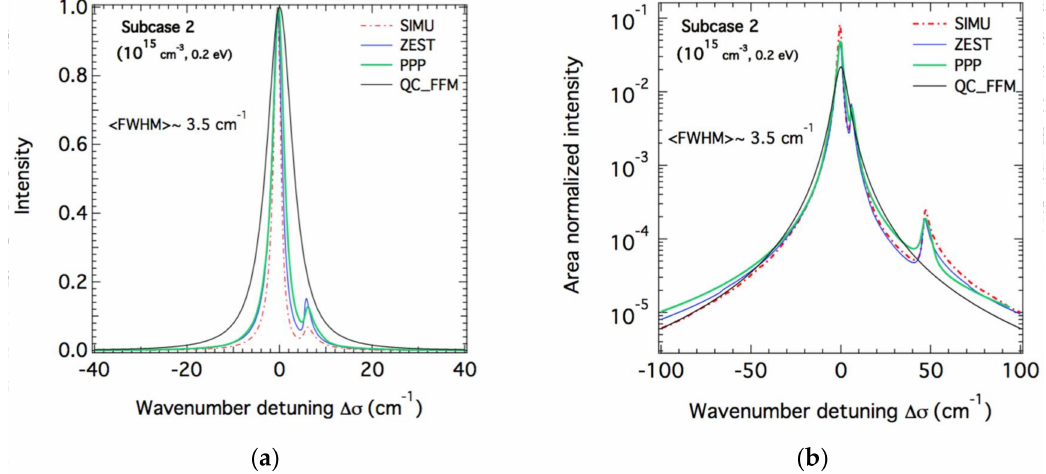
Figure 2. Same as Figure 1 but for T e = T i = 0.2